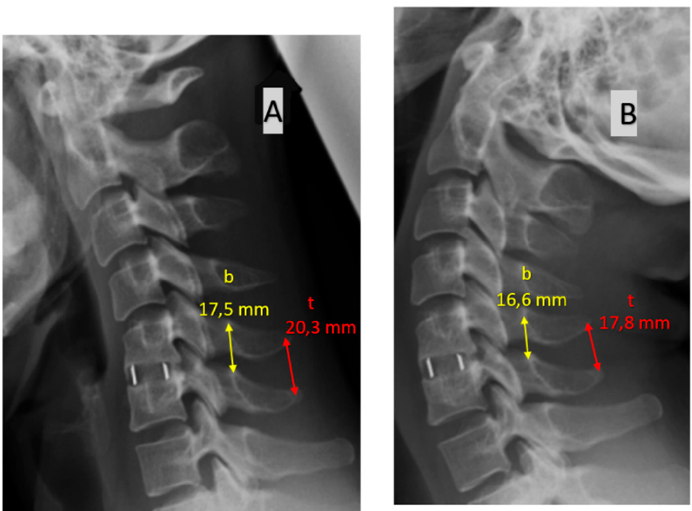
Figure 1. Assessment of bone fusion based on the change in the distance (in mm) in flexion ( A ) vs. in extension ( B ) between the bases of spinous processes (b) and between the tips of spinous processes (t). Greater interspinous distances are noted in flexion.